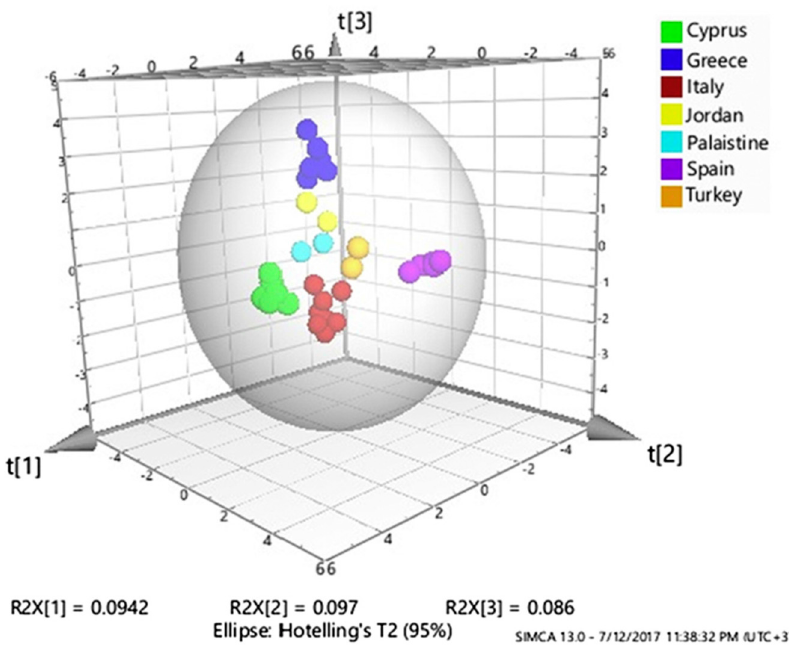
Figure 9. PLS plot from analysis on principal component analyses (PCAs) of 1st derivatives (2500–4000 cm − 1 ). Reproduced with permission from [141], Elsevier 2019.